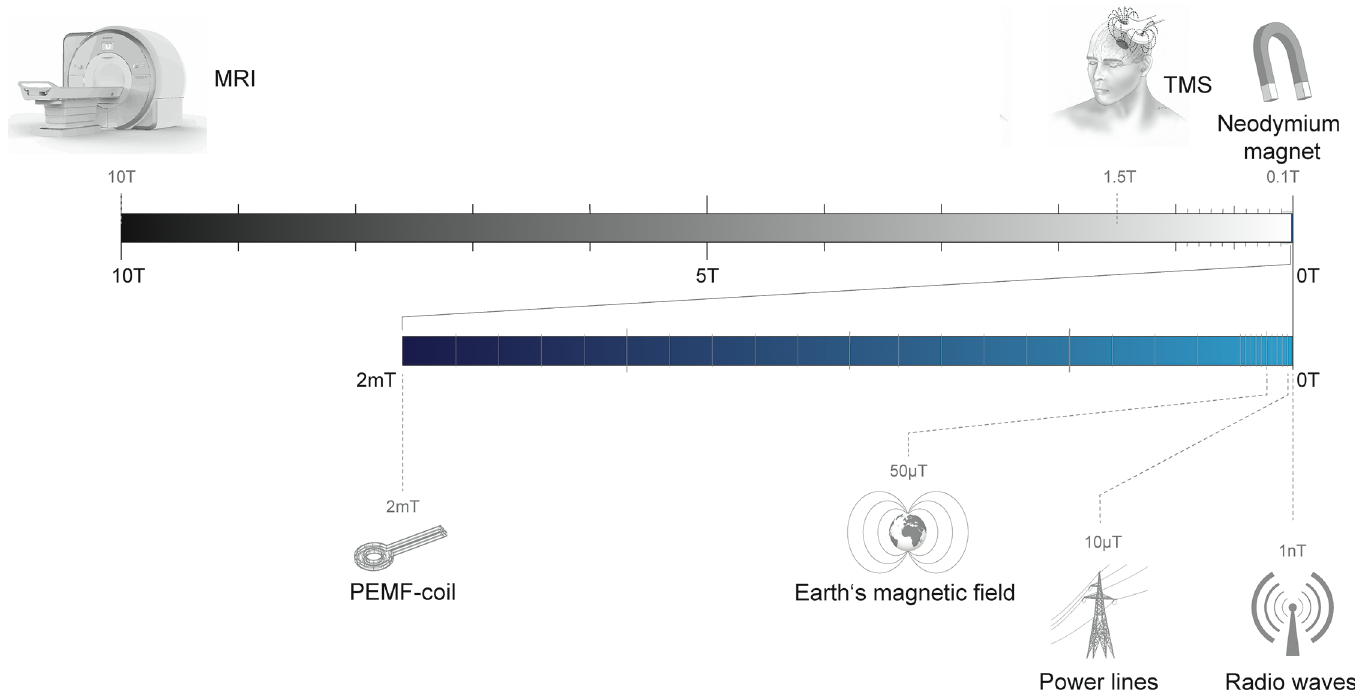
Fig 1. Diagram showing devices that generate magnetic fields and their respective field strengths. To date, most medically relevant magnetic fields are in the Tesla range and used for magnetic resonance imaging (1.5 T–10 T) or transcranial magnetic stimulation (1.5 T). Neodymium magnets produce static fields (100 mT), whereas low-flux PEMFs are in the range of 2 mT and oscillate in the range of 10 to 200 Hz. These fields are considerably stronger than the static field of the Earth (50 μ T), oscillating fields generated by powerlines (10 μ T, 50 Hz), and radio frequency waves (as low as 1 nT). Please note that the above field strengths should be considered as approximations, as there is considerable variation dependent on the device. PEMF, pulsed electromagnetic